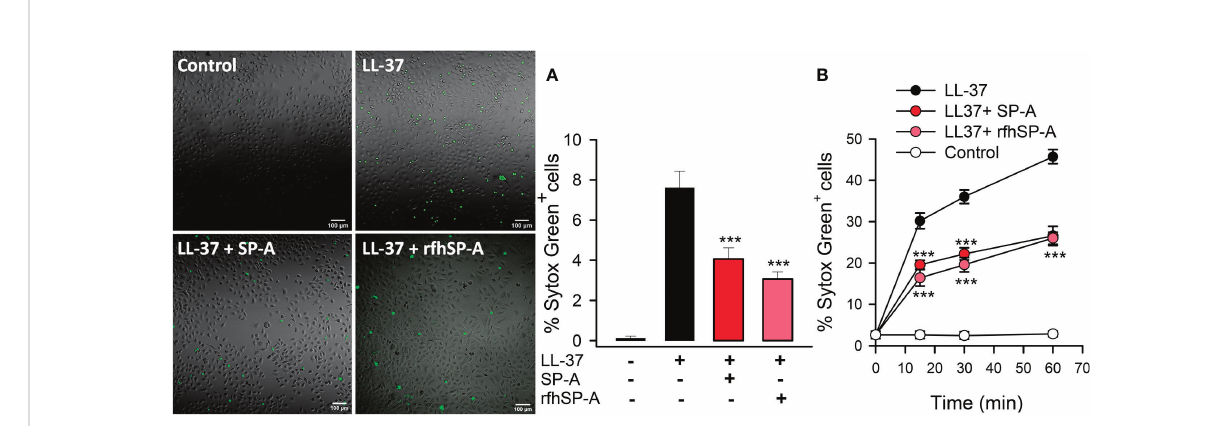
FIGURE 9 SP-A and rfhSP-A signi fi cantly reduce LL-37-induced uptake of Sytox Green by alveolar epithelial cells. Alveolar epithelial cells (A549 human cell line) were exposed to LL-37 (2.5 µM) in the presence or absence of SP-A (0.15 µM) or rfhSP-A (0.88 µM) for 30 min or the indicated times at 37°C. LL-37-induced Sytox Green (1 m M) incorporation into cells was analyzed by confocal microscopy (A) and fl ow cytometry (B) . In A, representative confocal micrographs and quanti fi cation of the % of Sytox Green+ cells are shown. Data are means ± S.E.M. of three